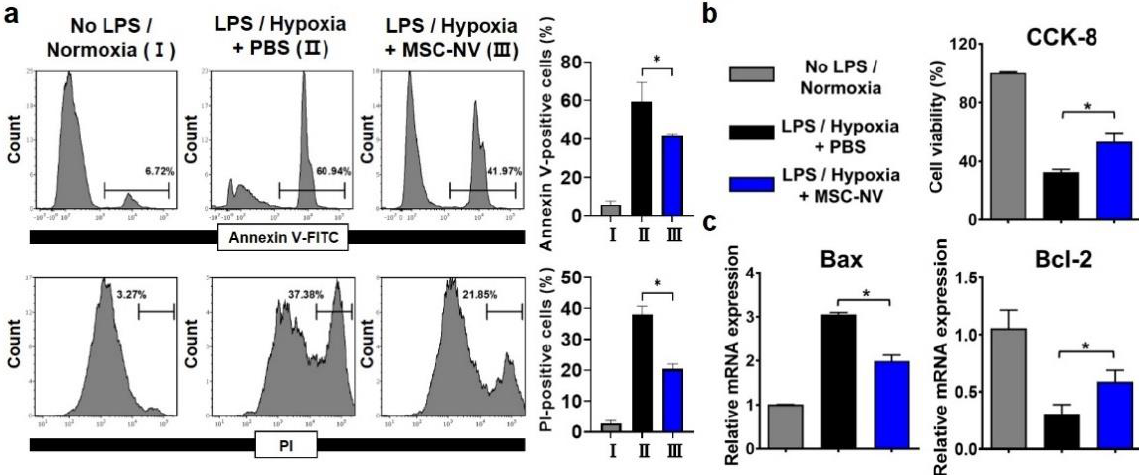
Figure 4. Apoptotic behavior of PC12 cells pretreated with MSC-NVs for 16 h and exposed to proinflammatory (LPS) and hypoxic (1% oxygen) conditions for 24 h. ( a ) Cells were double-stained with annexin V-FITC and propidium iodide (PI) and determined using flow cytometry. Quantitative analysis of flow cytometry was also carried out. n = 3, * p < 0.05. ( b ) Cell viability of PC12 cells measured by CCK-8 assay. n = 3, * p < 0.05. ( c ) mRNA expressions of Bax (proapoptotic) and Bcl-2 (anti-apoptotic) in PC12 cells, as evaluated by RT-PCR. n = 3, * p < 0.05. Three independent experiments were carried out, and the p -values were calculated by the one-way analysis of variance (ANOVA) with Tukey’s post hoc test.